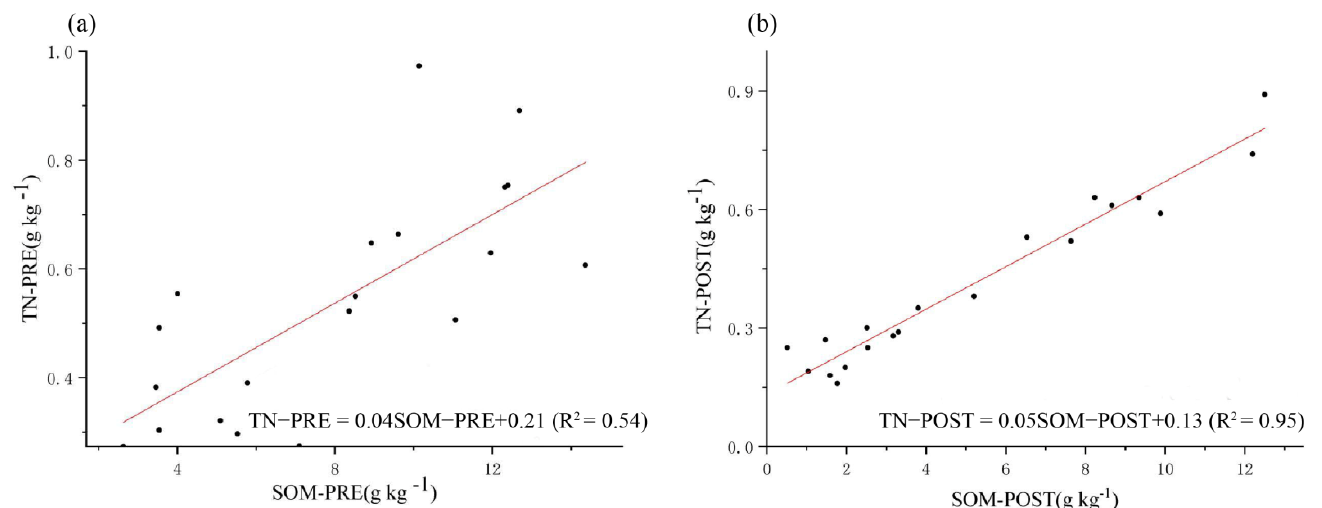
Figure 3. The linear regression fitted between ( a ) SOM in pre-mining soil and TN in pre-mining soil, and ( b ) SOM in post-mining soil and TN in post-mining soil.